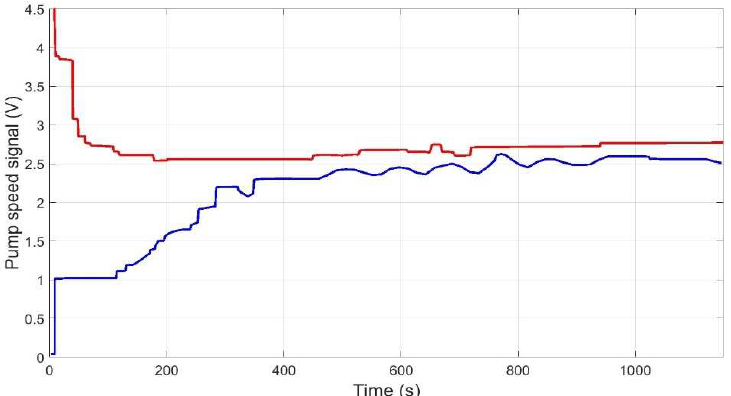
Figure 17. Evolution of pump speed control action to reach the representative operating point (P_ref = 2 bar, Q r _ref = 54 L/h) using inverse local models (blue), and expert control based on fuzzy logic (red).